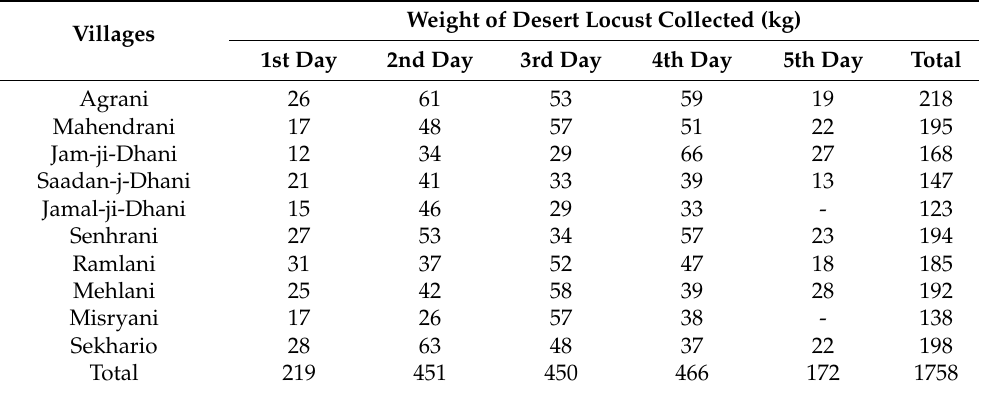
Table 2. Collection of desert locusts by villagers after the arrival of the second swarm on 24 September 2019. Weight of Desert Locust Collected (kg) Villages 1st